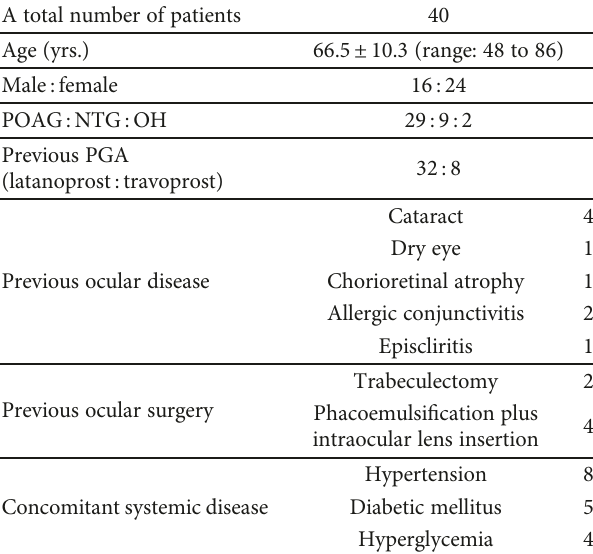
Table 1: Patient